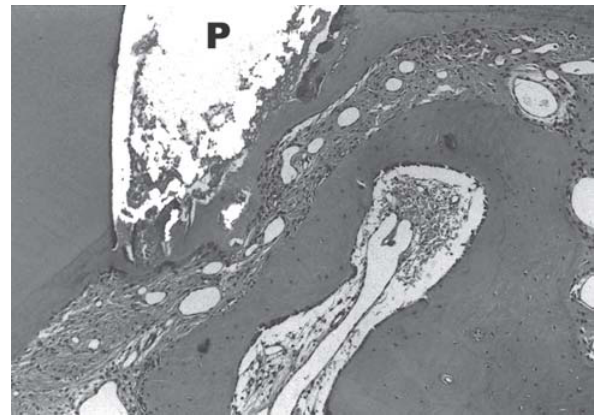
FIGURE 2- MTA-Angelus, demonstrating new formation of mineralized tissue sealing the perforation (P), with no inflammation and with normal condition of the periodontal ligament. Hematoxylin and eosin – Olympus